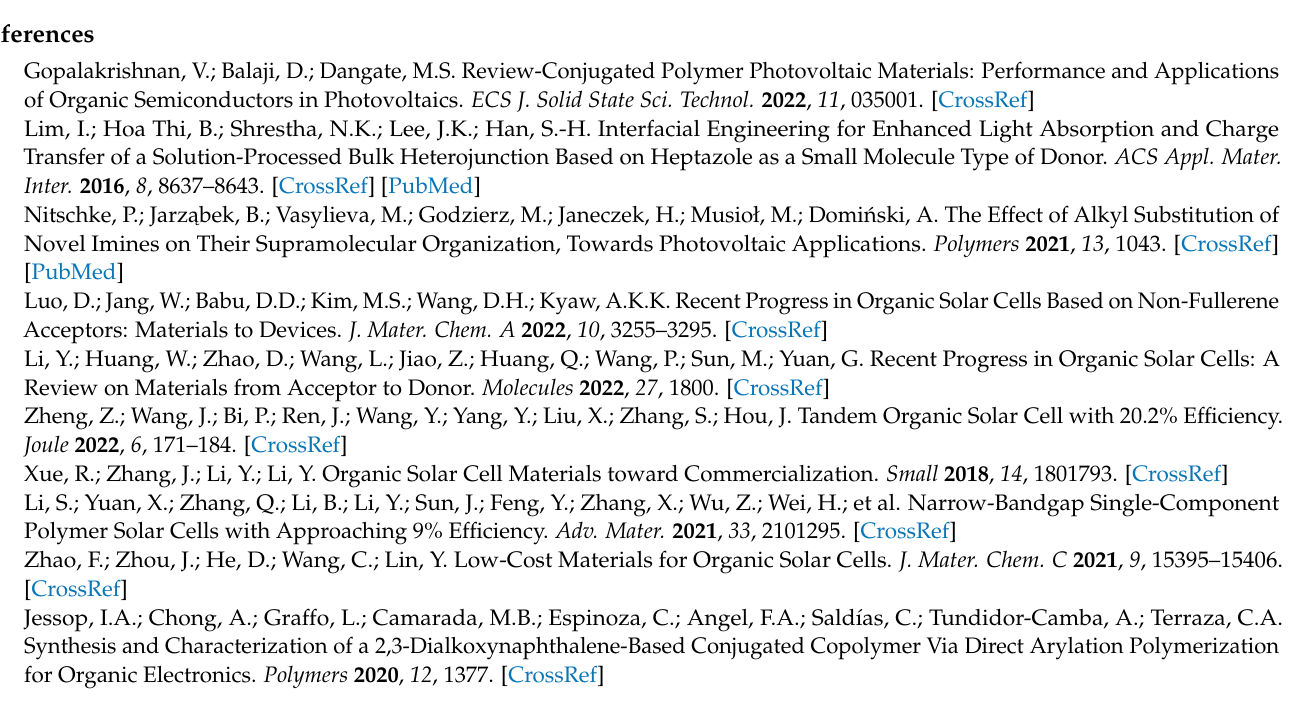
Table S1; Figure S8: Chemical structures of PBDB-T and PBDB-T-2F; Figure S9: Chemical struc- tures of Y6; Table S1: Survey of polymer solar cells based on some representative low-cost and efficient donor polymers materials; Table S2: Survey of calculated chemical synthesis costs for PIQ ; Table S3: Comparison of the synthetic steps and synthesis costs for polymer donor